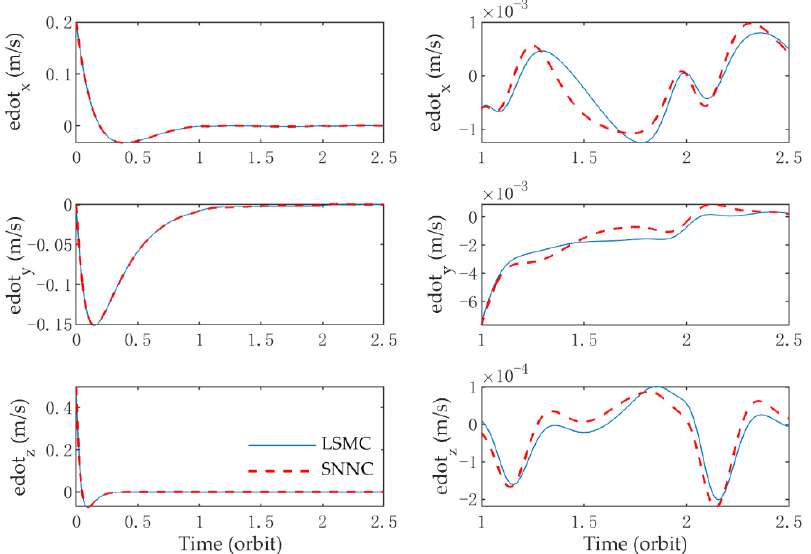
Figure 7. Time histories of relative velocity errors for the case without in-track control.